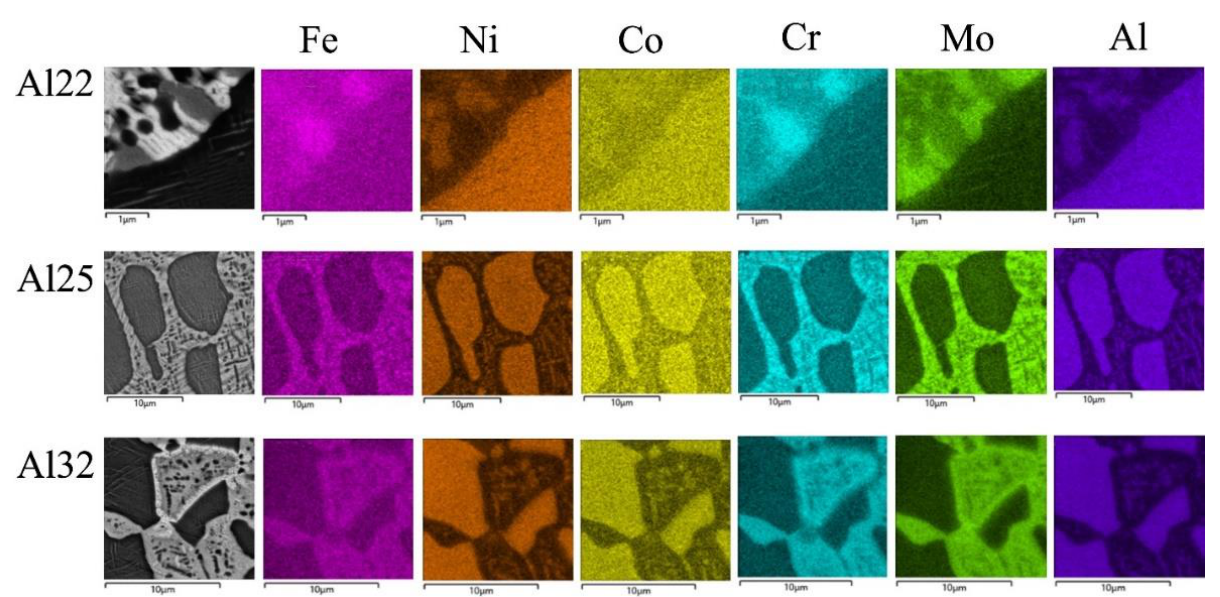
Figure 5. Elemental distribution in the Al22, Al25, and Al32 alloys.